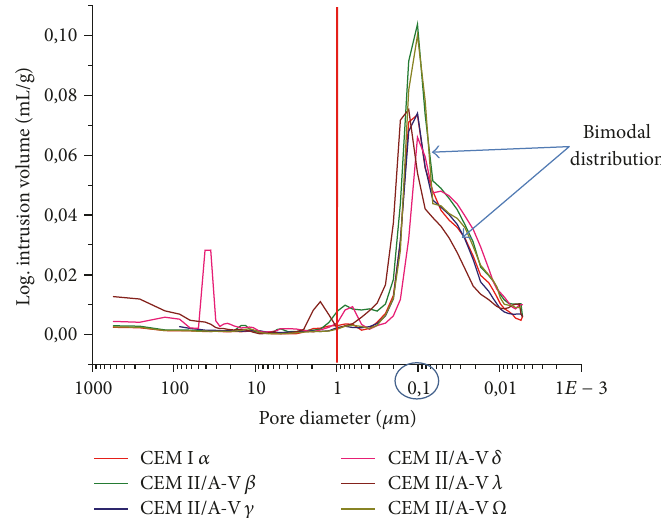
Figure 6: Mercury intrusion porosimetry (MIP) results at 28